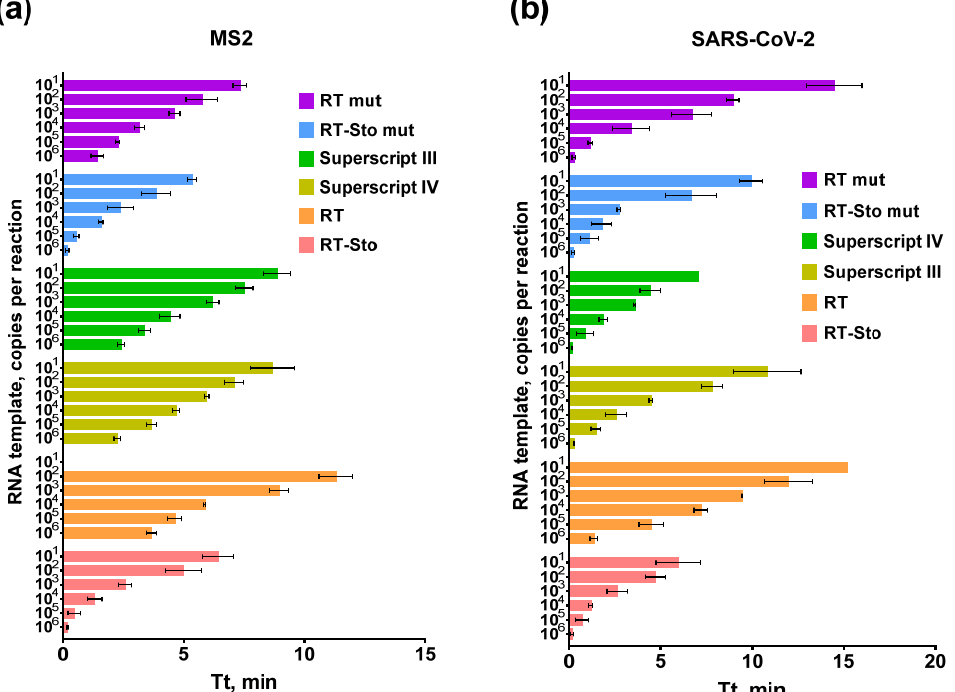
Figure 5. RT-LAMP with RNA template titration and primers for MS2 ( a ) and SARS-CoV-2 ( b ). The temperature of the reverse transcription step was 55 °C for RT and RT-Sto and 60 °C for the remaining enzymes. Each enzyme is marked by the color specified in the legend. Time-to-threshold (Tt) values are presented on the X-axis and the RNA template concentration is shown on the Y-axis. Each experiment was triplicated, with error bars representing one SD.